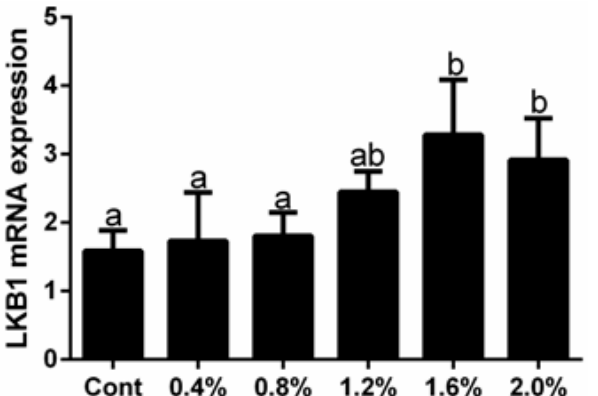
Figure 8. The effects of lysine-glutamate dipeptide diets with different concentrations on LKB1 expression. Different percentages represent different concentrations of dipeptide. Data are presented as means ± SE ( n = 3). Different letters indicate significant differences ( p < 0.05).